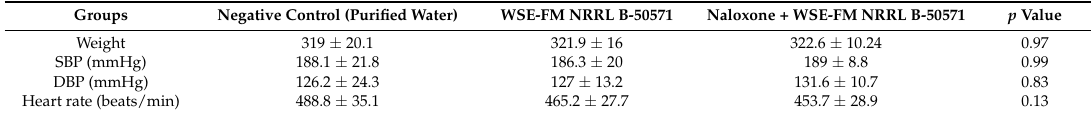
Table 1. Clinical characteristics of